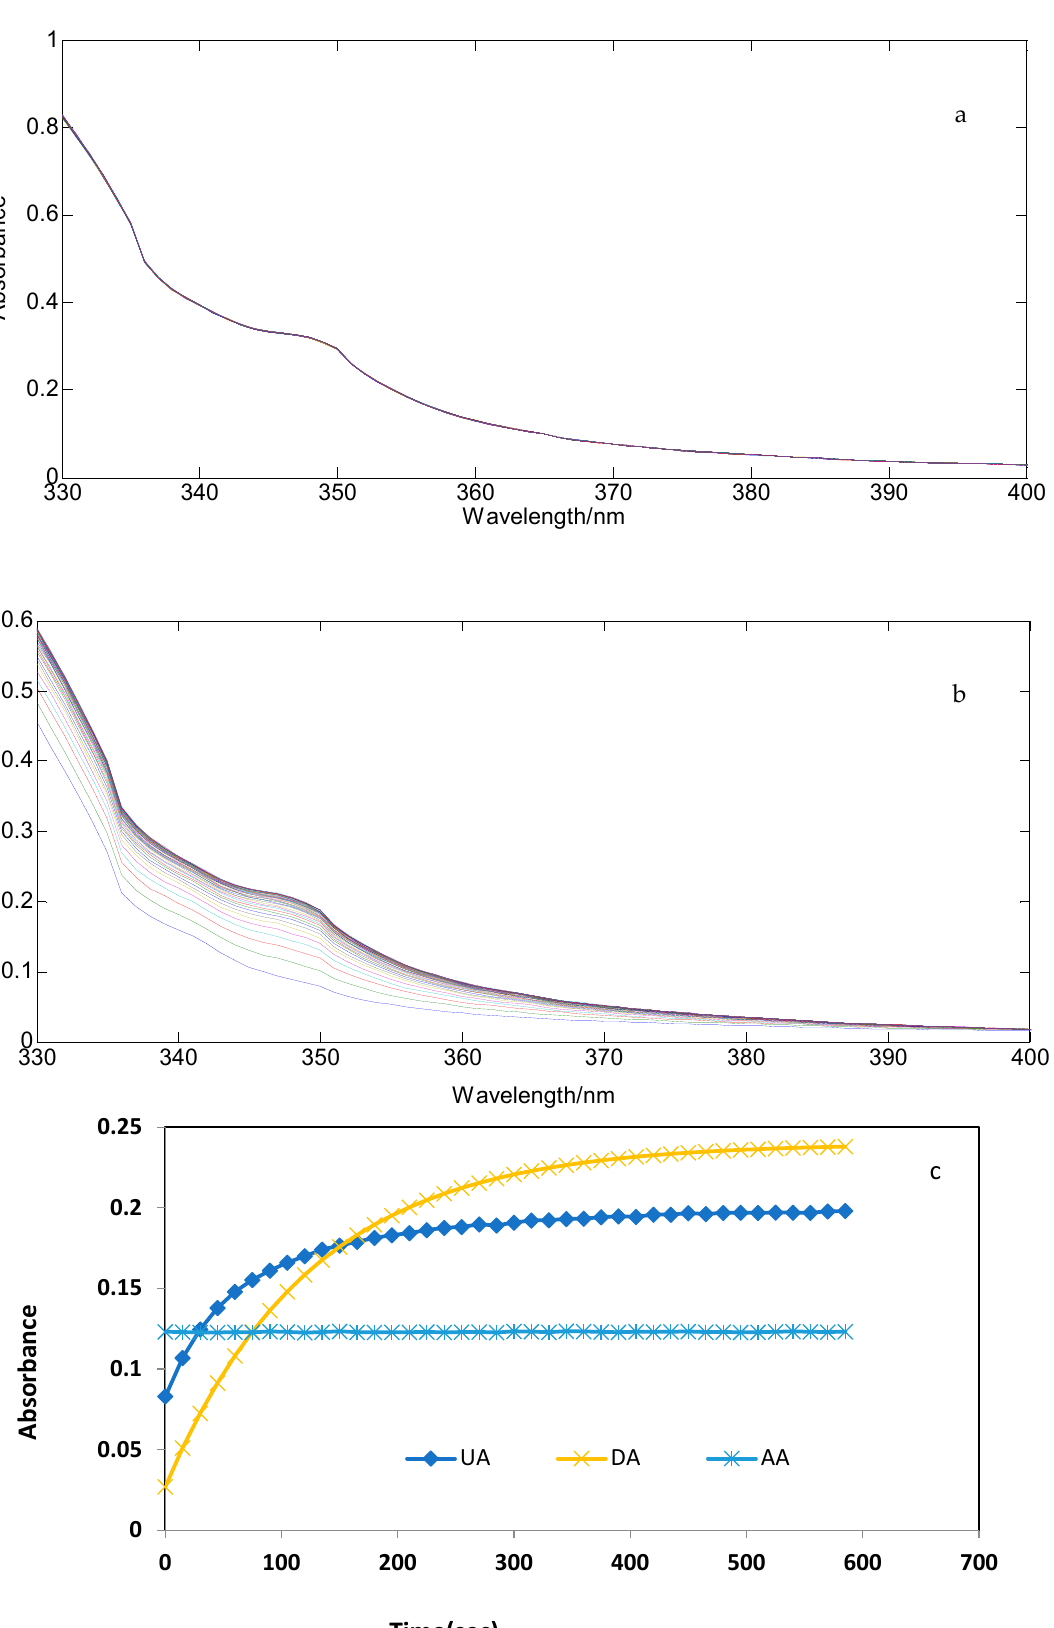
Figure 2. Effect of pH on absorbance variation of DA and UA. 3.2. Individual Calibration Graphs of UA and DA Different concentrations of UA and DA were prepared, and measurements were car- ried out. The calibration curves were obtained. The obtained linear ranges, correlation coefficients, LODs and LOQs are presented at Table 1. Table 1. Statistical results of calibration graphs obtained at zero-crossing points using CWT-sym8. LOQ/ μ M LOD/ μ M 2 R Regression Equation Dynamic Range Time (s) Analyte 0.19 0.06 0.984 CWT = 0.0051C UA + 0.002 2.0–50.0 220 UA